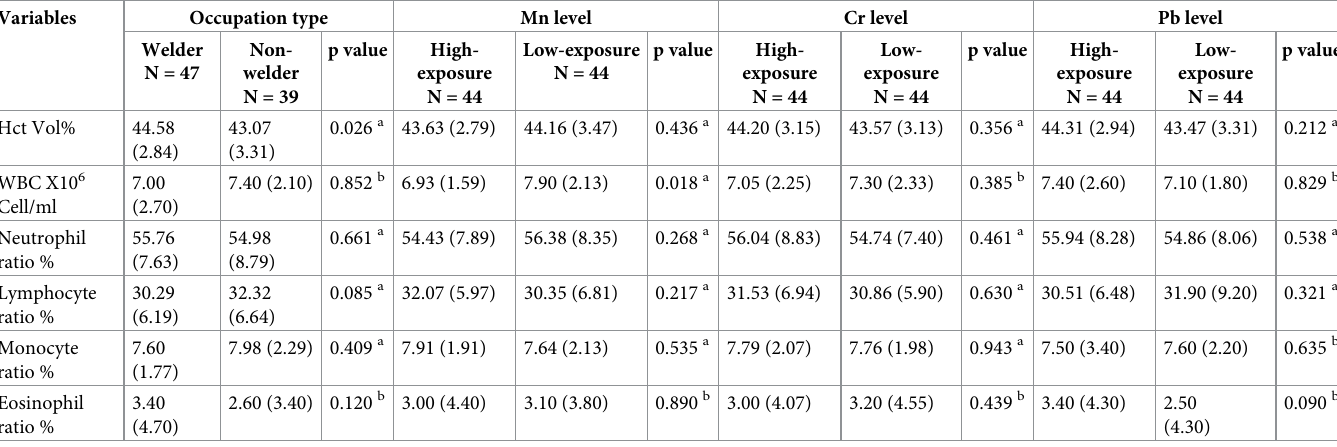
Table 3. Characteristics of hemostatic blood parameters stratified by occupation type and metal level